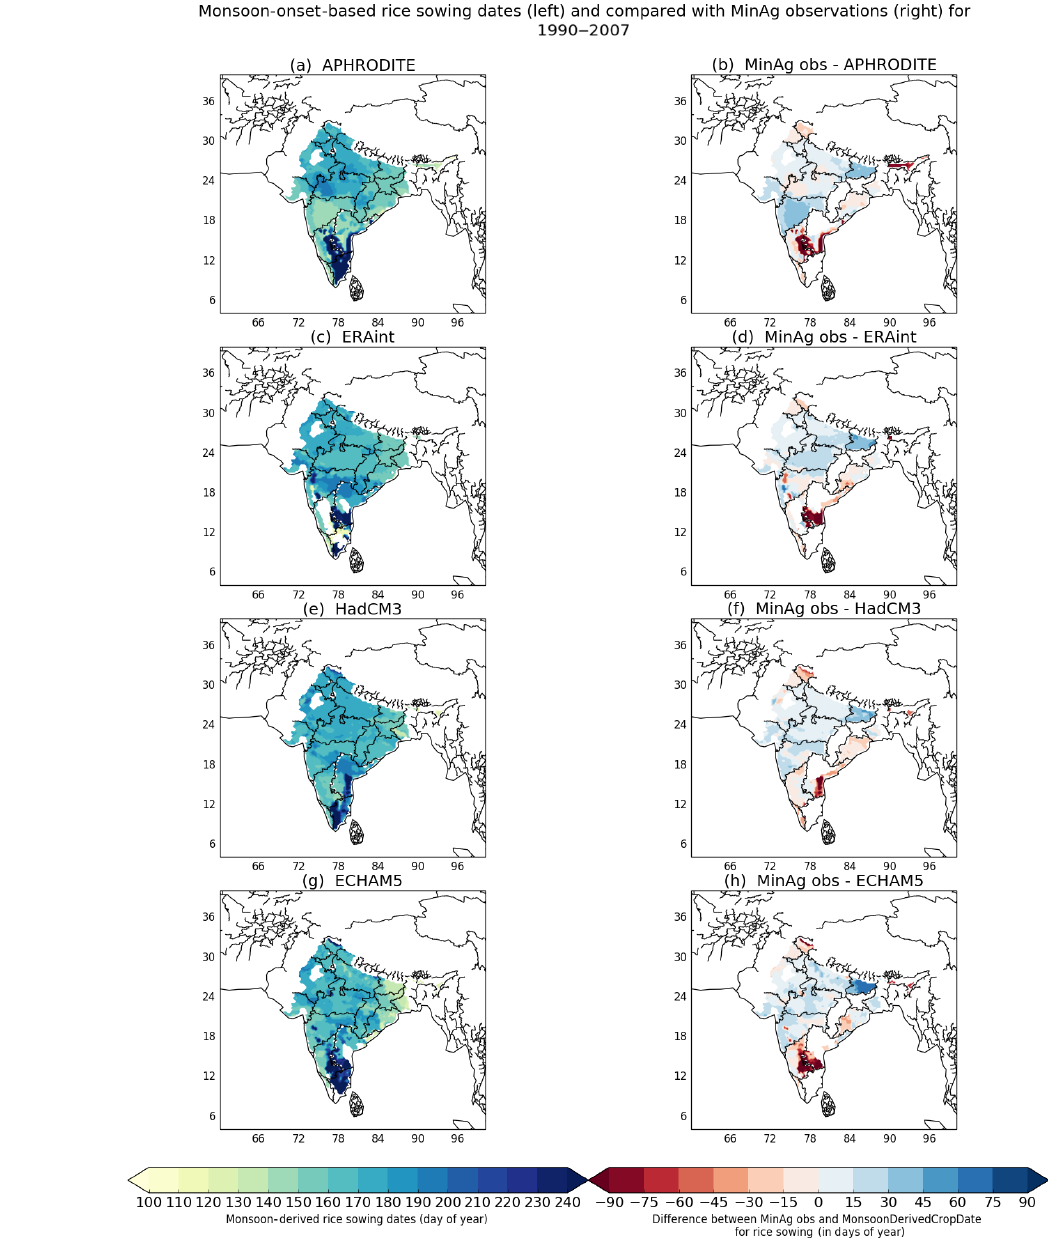
Figure 7. The monsoon-derived rice sowing dates (a, c, e, g) and the difference between the MinAg observations and the monsoon-derived rice sowing dates (b, d, f, h) for the period